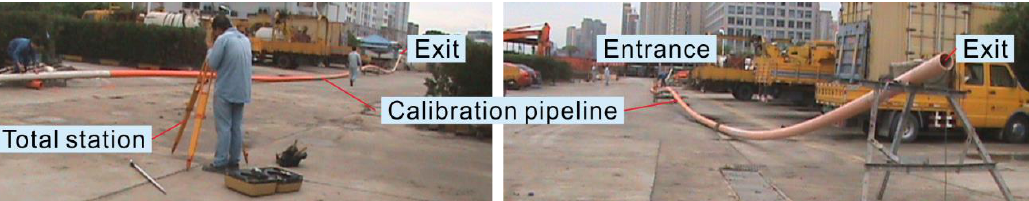
Figure 9. Instrument calibration test site.